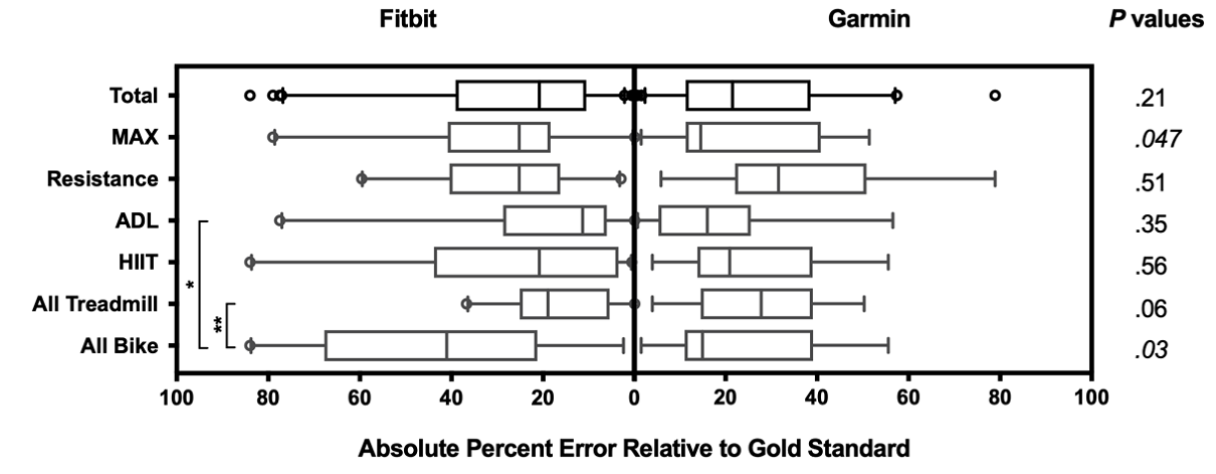
Figure 7. Absolute percent error in energy expenditure (EE) across different exercise modalities for Fitbit and Garmin. Each box-whisker plot consists of a box that extends from the 25% to the 75% quartile, with a line in the middle of the box representing the median (50% quartile). Each box has error bars that extend to the 5% and 95% quartiles, with outliers displayed with open circles. The P values listed on the right side display the difference in absolute percent error for EE between Fitbit and Garmin during each activity with italics indicating statistical significance. Asterisk and double asterisks indicate P =.02 and P =.003, respectively. ADL: activities of daily living, HIIT: high-intensity interval